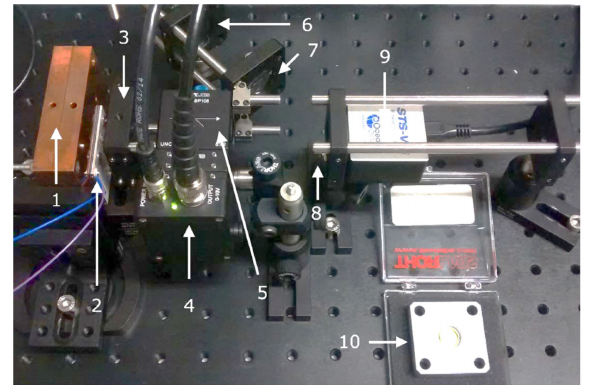
Figure 1. LED-based photoluminescence measurement setup.